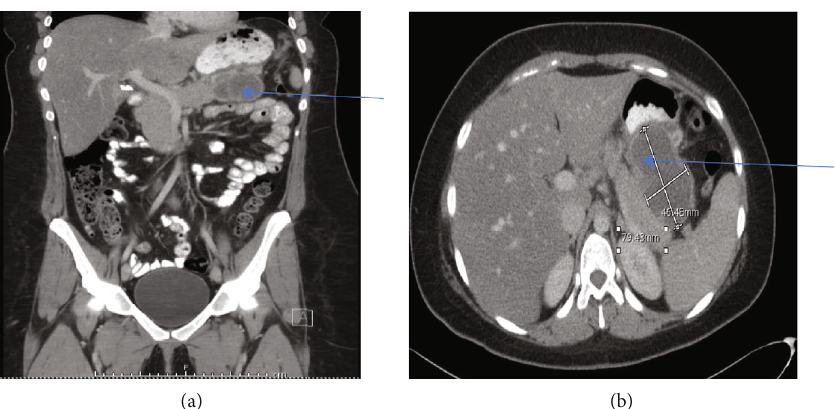
Figure 1: CT of the abdomen and pelvis with oral and IV contrast showing a large multilobulated upper abdominal mass (arrow) inseparable from the body and tail of the pancreas (a). The tumor ( 10 cm × 9cm × 7cm ) fi lled the lesser sac (arrow) and wrapped around the gastric fundus